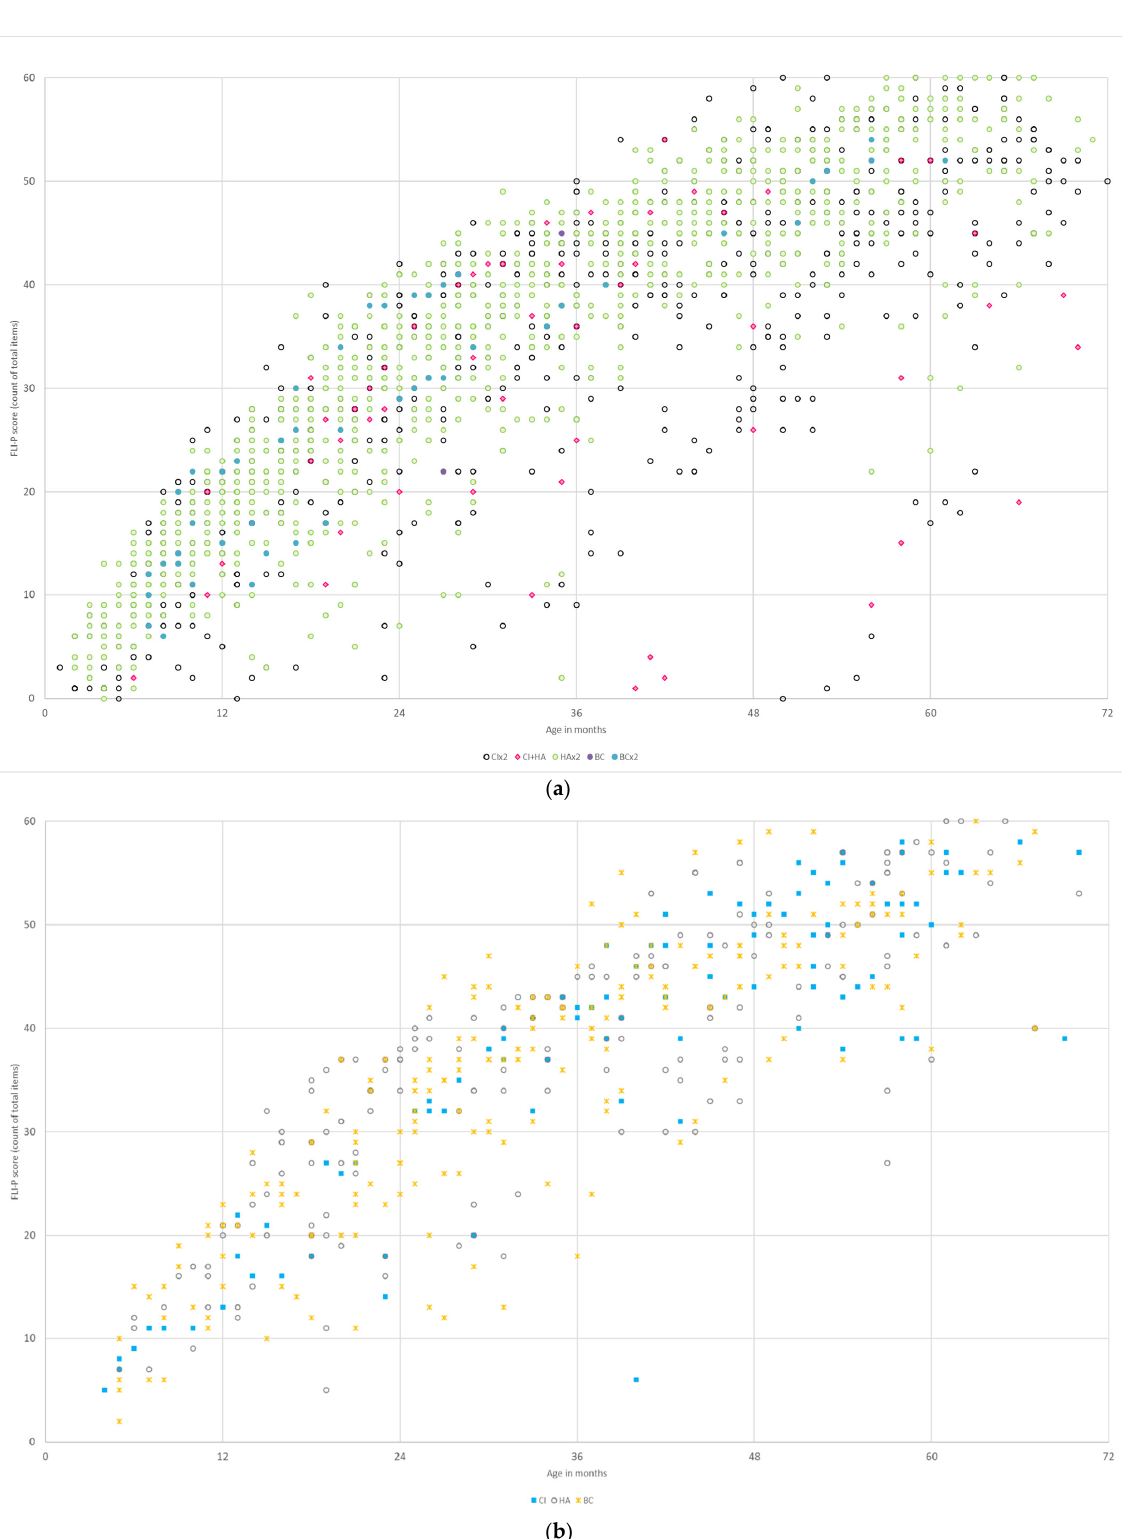
23 of 35 Figure 10. FLI-P scores between groups of children who ( a ) received a refer newborn hearing screen- ing result and ( b ) who received a result. The FLI-P scores of children diagnosed with a hearing loss following newborn screening in this study is consistent with the large body of evidence that early diagnosis enables the early development of auditory skills to support language acquisition [27–29]. In this study, variation in listening skill development as measured by the FLI-P was ob- served particularly for children at older ages who passed screening. Given the potential time gaps between the onset of the hearing loss following screening and diagnosis/fitting of devices, these FLI-P scores match the expected pattern. 3.3.6. Type of Device FLI-P scores were compared by type of hearing device. Devices were categorized ac-